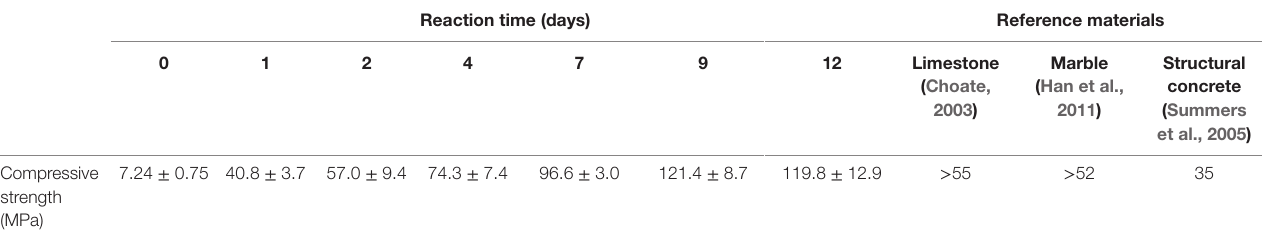
TaBle 3 | compressive strength of casiO 3 compacts during “solution replacement” reaction.